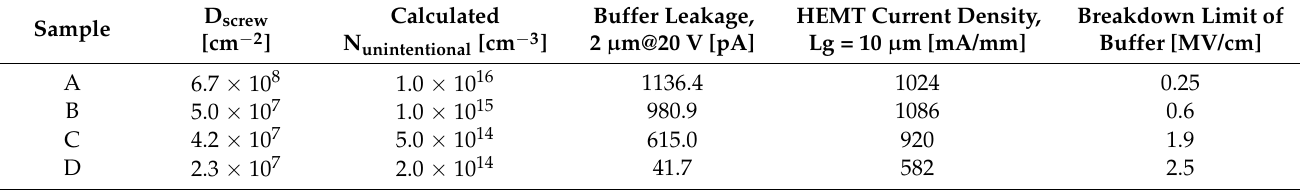
Table 3. A summary of each sample’s performances in five categories: screw dislocation density, cal- culated unintentional doping concentration, buffer leakage for a 2 µ m spacing, maximum saturation current density for a full HEMT device, and breakdown limit of the